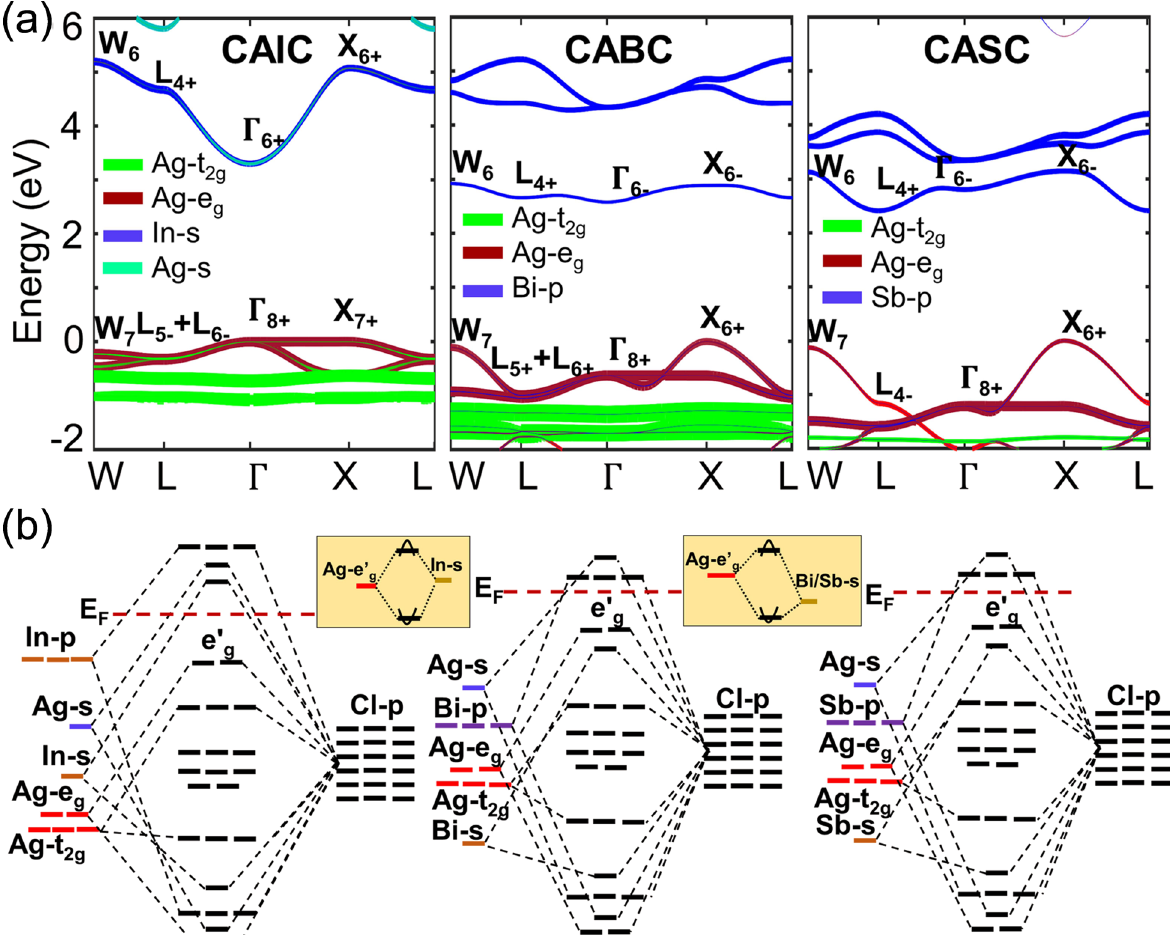
Fig. 2 Band structure of halide double perovskites. a Band structure of CAIC, CABC, and CASC with a display of dominant orbital characters. The parity of the valence and conduction band edges is shown in Koster notations. b The corresponding molecular orbital pictures as obtained by analyzing the orbital- resolved band structure and density of states (not shown here). In the inset, the nature of the hybridization among the hybridized Ag-e g and In/Bi/Sb-s orbitals is schematically shown to distinguish the shape of the dispersion in valence and conduction band edges in these